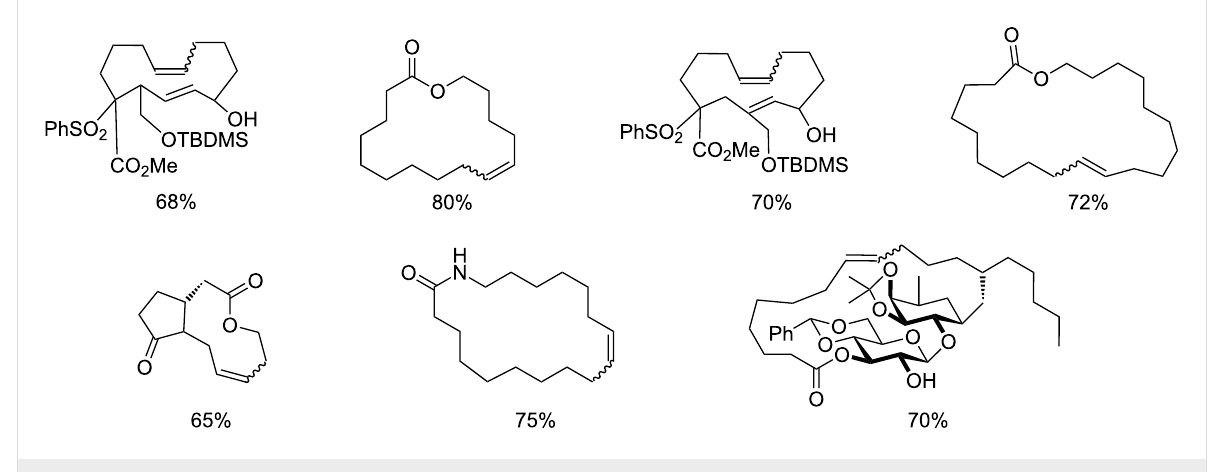
Figure 6: Some of the rings produced by photo-RCM.